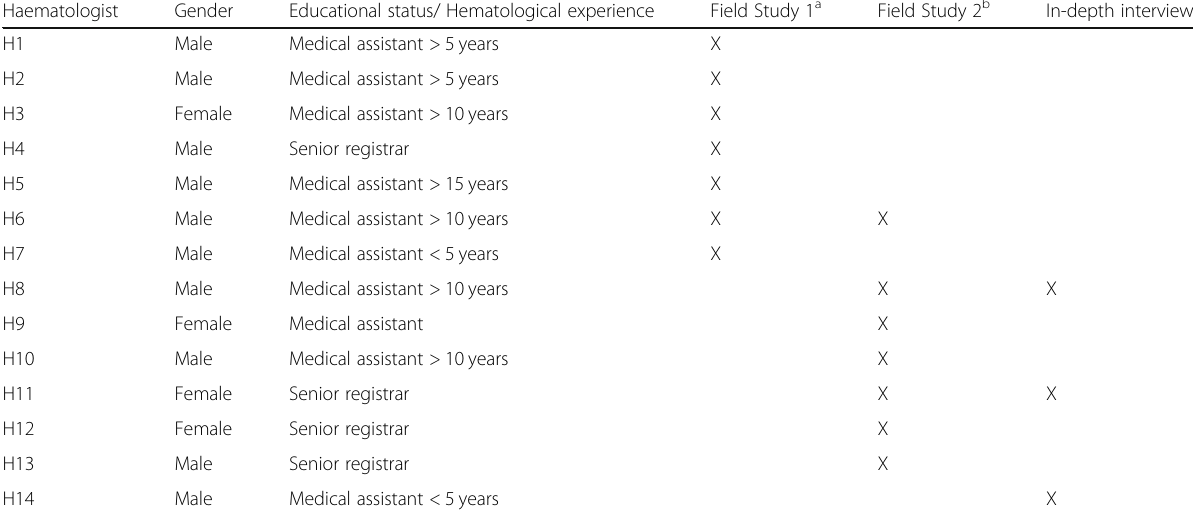
Table 1 Participants in data collection